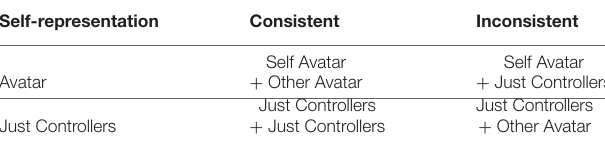
Self Avatar + Other Avatar Just Controllers + Just Controllers